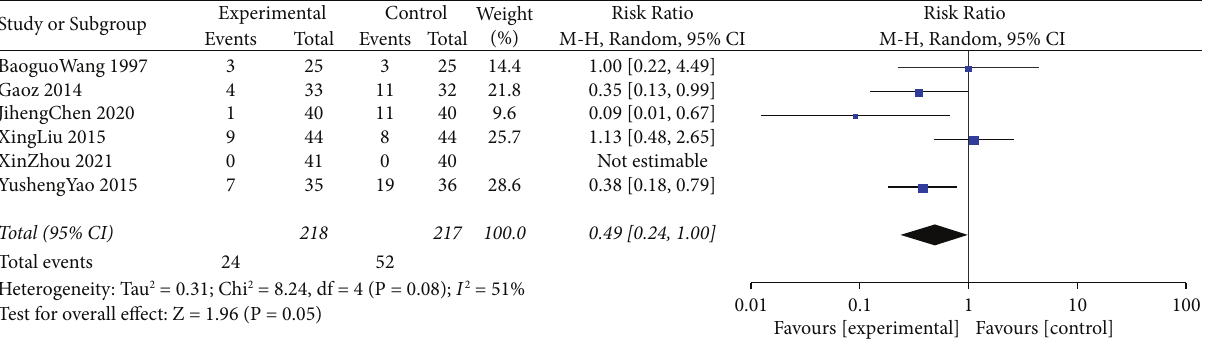
Figure 6: Forest plots comparing the incidence of postoperative vomiting between the TEAS and control